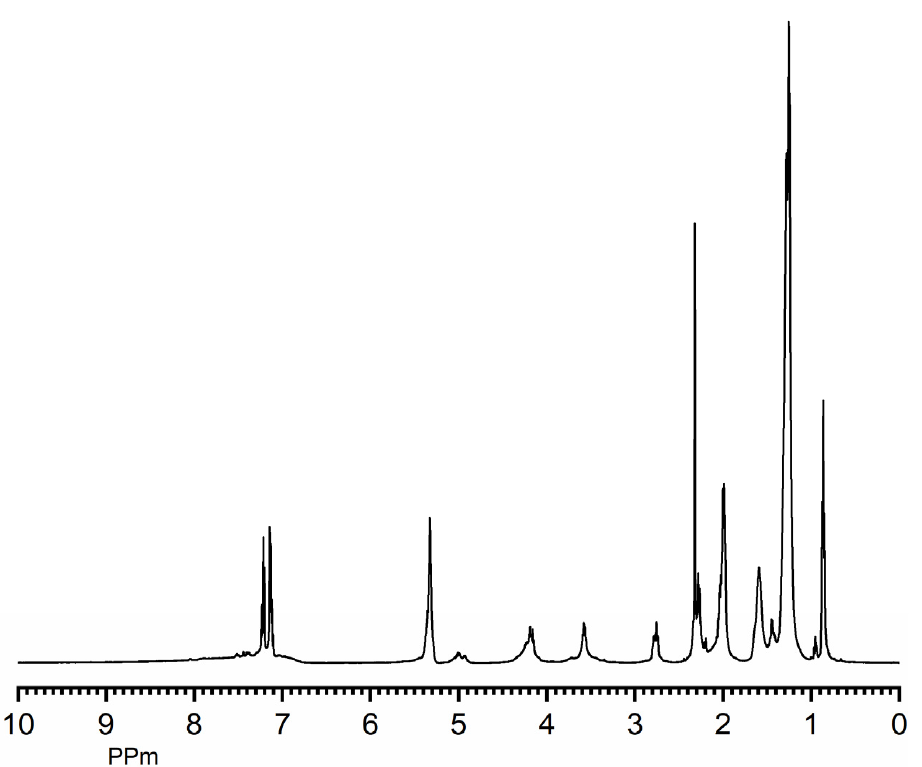
Figure 2. 1 HNMR spectrum of CPEEUA for structure elucidation.